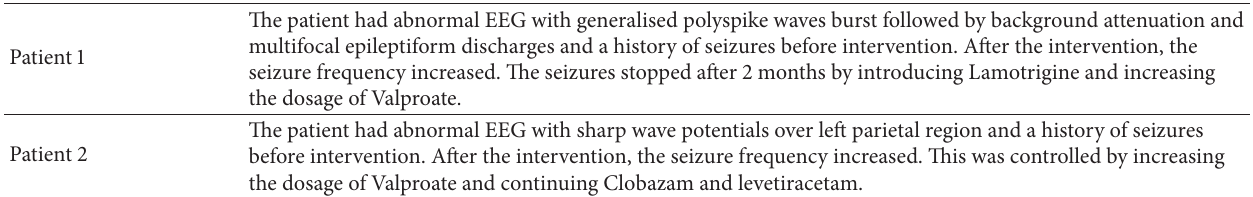
Table 6: Details of two patients who had seizures as an adverse event after cellular therapy.